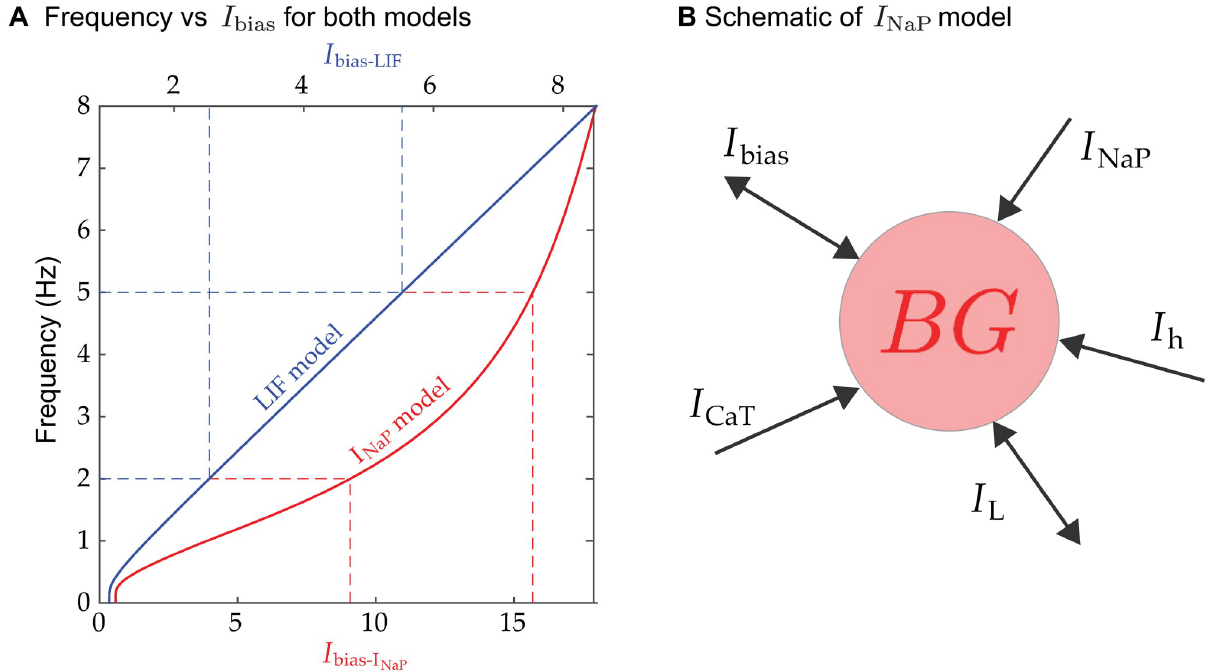
Fig 2. Biophysical models. A . Frequency vs. I bias curves for LIF (blue) and I NaP (red) models. Observe the different scales for the upper and lower horizontal axes. Dashed lines show the corresponding I bias values for two different frequencies. Both curves are increasing, starting from zero frequency, which yields qualitatively similar behavior from either model. While the LIF relation is almost linear for frequencies larger than 1 Hz, the I more power-like, with a steeper gradient from 3 to 8 Hz, this yields differences in the quantitative behavior of the models. B . Schematic of I NaP neuron with the different ionic currents that contribute to its excitability and spiking